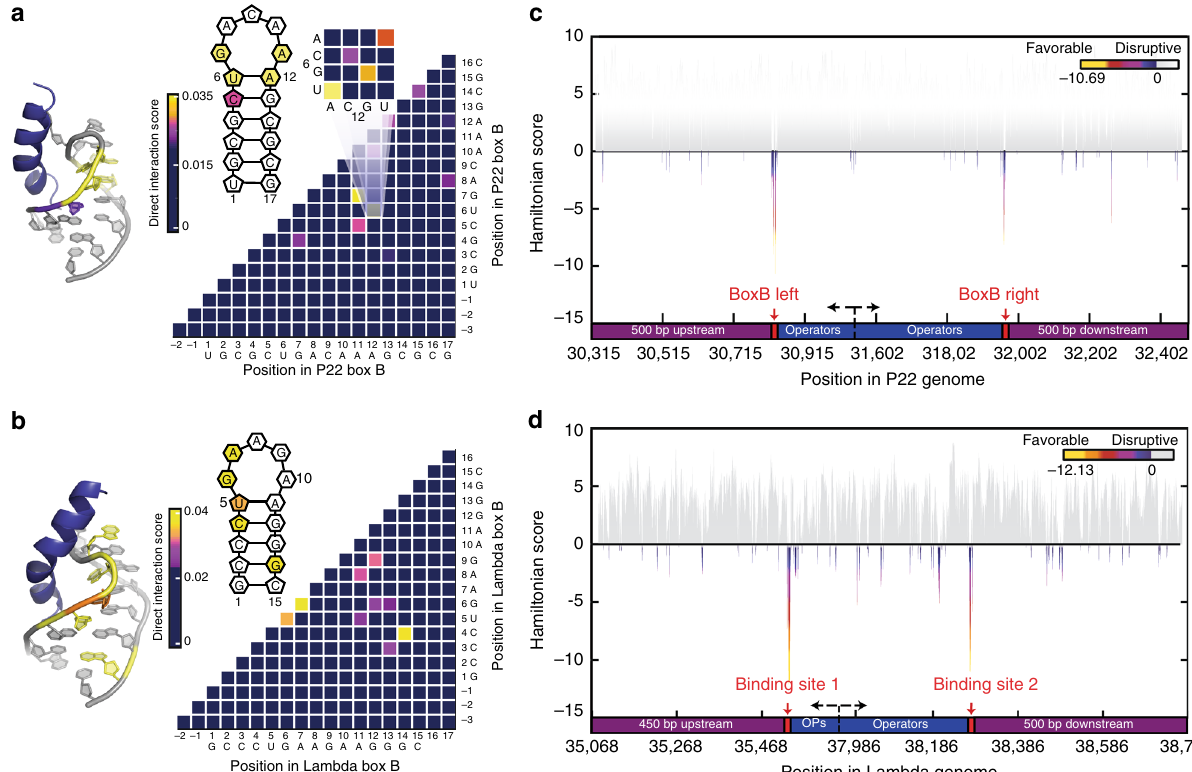
Fig. 2 DCA-scapes of N proteins reveal known sites of association in vivo. a The structure of P22 N (PDB 1A4T [https://www.rcsb.org/structure/1A4T]) bound to box B motif is shaded according to direct information (DI) score. Yellow bases have the highest score while darker colors denote lower scores. A cartoon of the box B structure is shown to indicate the position of shaded sites in the 3D coordinates. The DI landscape indicates coupled relationships in the box B motif. b The structure of λ N (PDB 1QFQ [https://www.rcsb.org/structure/1QFQ]) bound to box B, a cartoon indicating speci fi c coupling interactions observed on the DI landscape. c Discovery of in vivo-binding sites for P22 N based on Hamiltonian scores. Hamiltonian scores ( Y -axis) across the genomic region encompassing the operator region are calculated based on estimated global probability parameters using DCA and provide a quantitative evaluation of binding in different genomic regions. Negative values indicate a higher probability of association and are shaded according to the inset color bar. d Predicted binding sites for λ N following the same procedure as in